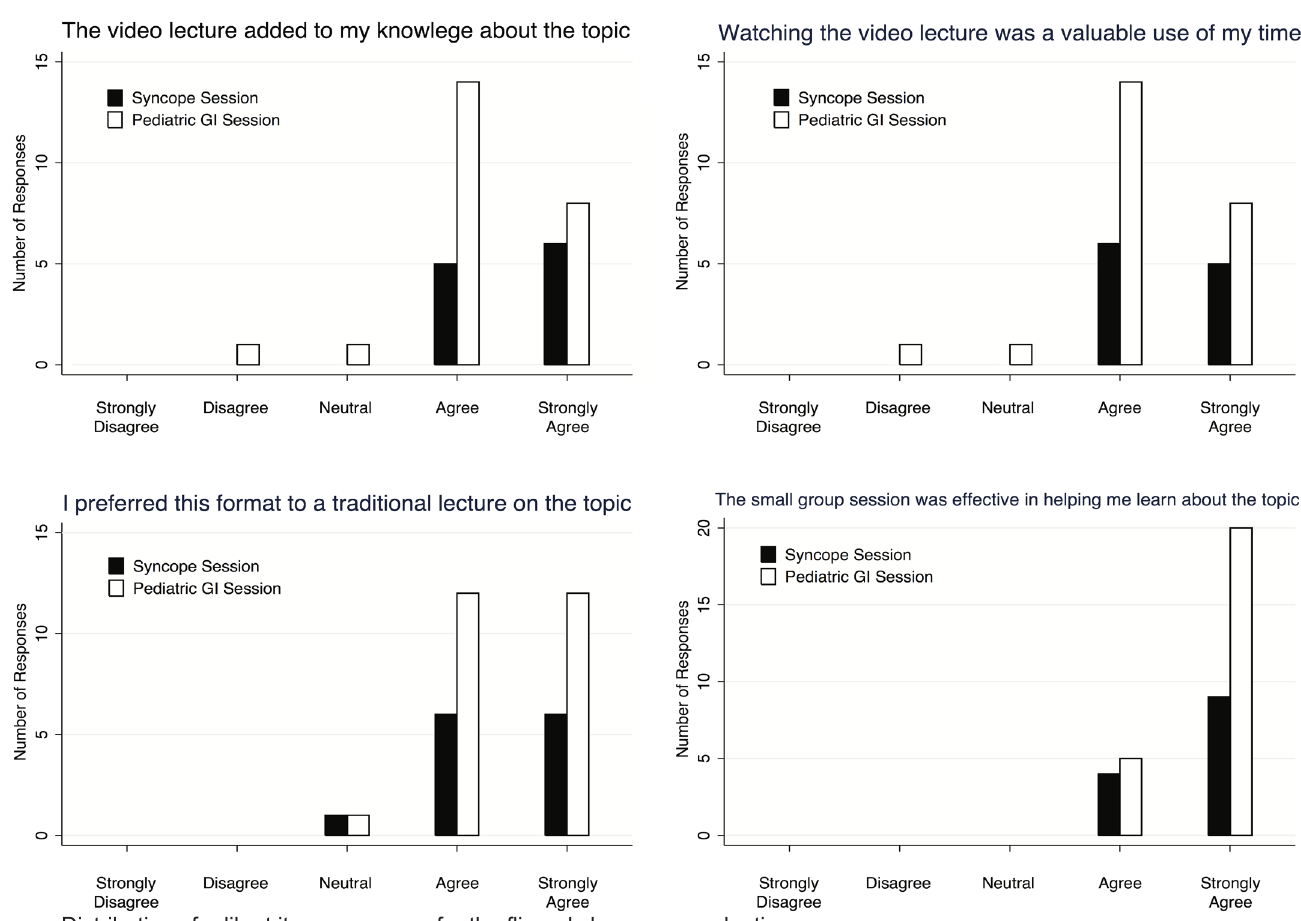
Figure. Distributions for likert item responses for the flipped classroom evaluation survey. GI, Table 1a . Tabulated responses of residents to flipped classroom survey.